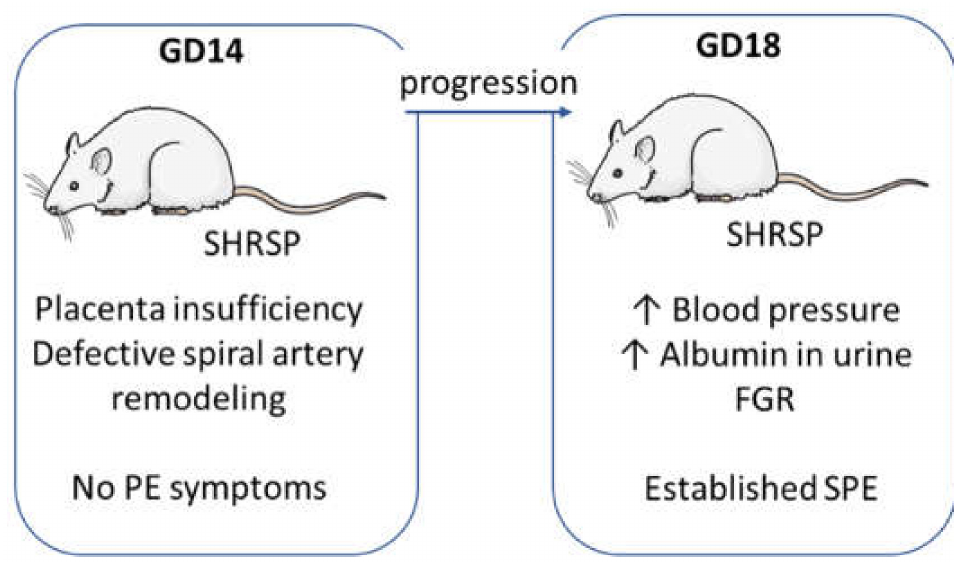
Figure 1. Summary of the superimposed preeclampsia (PE)-like features observed in SHRSP preg- nancies. Gestation day (GD) 14 corresponds to the onset of disease, characterized by defective placentation and impaired arterial remodeling defects without full development of maternal fea- tures. As pregnancy progresses towards GD18, blood pressure rises steadily presenting the typical features observed in superimposed preeclampsia: aggravated hypertensive condition, end-organ damage (i.e., renal dysfunction with glomerular enlargement and proteinuria) and FGR (described in detail in